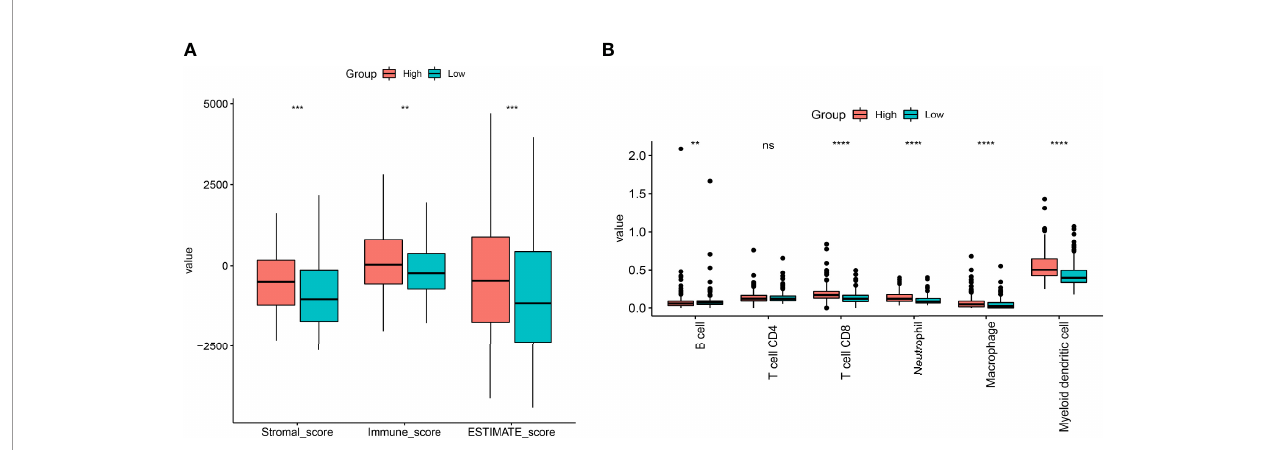
FIGURE 11 | The immune cell in fi ltration in BC. (A) The analysis of the stromal score, immune score, and ESTIMATE score between the high and low nuclear MTRGs score groups. (B) The estimate of immune cell in fi ltration via a deconvolution algorithm of TIMER. **p < 0.01, ***p < 0.001, ****p < 0.0001, ns, not signi fi